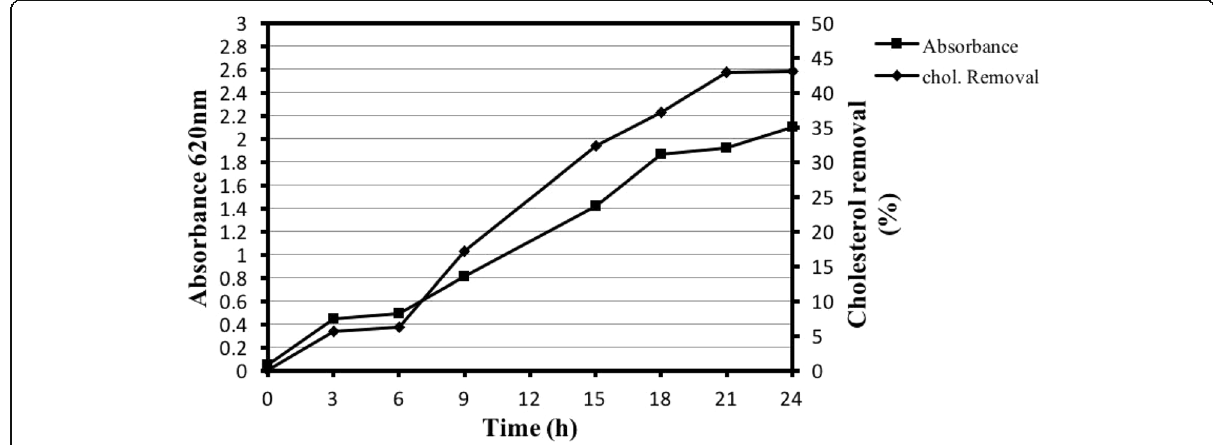
Fig. 1 Growth profile of Lactococcus lactic subsp. lactis in medium containing cholesterol, and the cholesterol assimilation curve